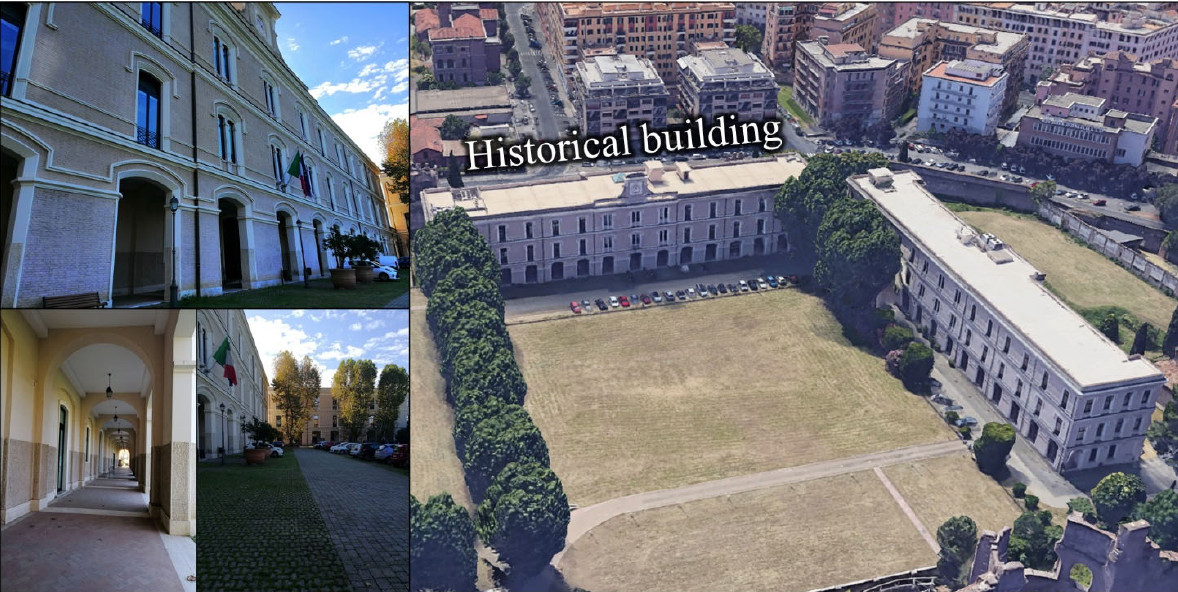
Figure 1. Aerial view of the archaeological area of the historical building.